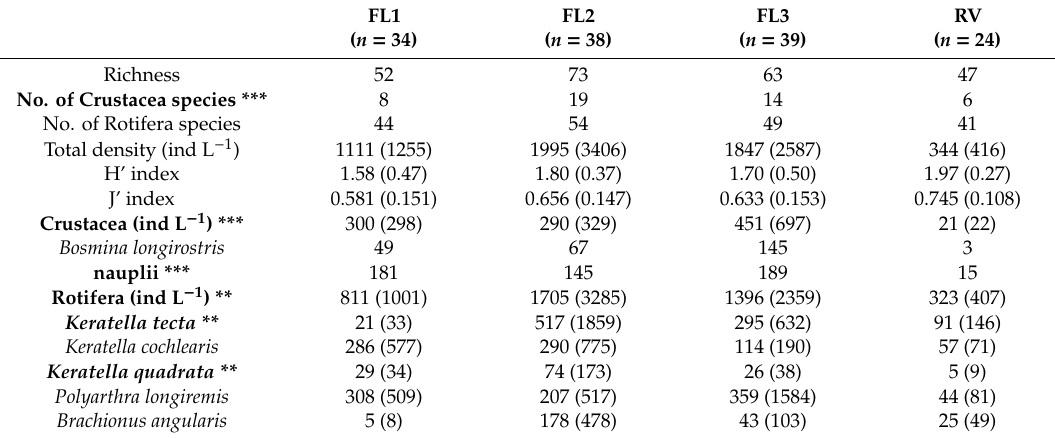
Table 3. Zooplankton structure of the investigated floodplain lakes and the Vistula River. Data present the mean (s.d.) for every samples between 2006 and 2013, including only dominant taxa (D > 10%). H’— α -diversity, J’—evenness. Significant di ff erences (nonparametric Kruskal–Wallis test; ** p ≤ 0.01; *** p ≤ 0.001) among the investigated water bodies are shown in